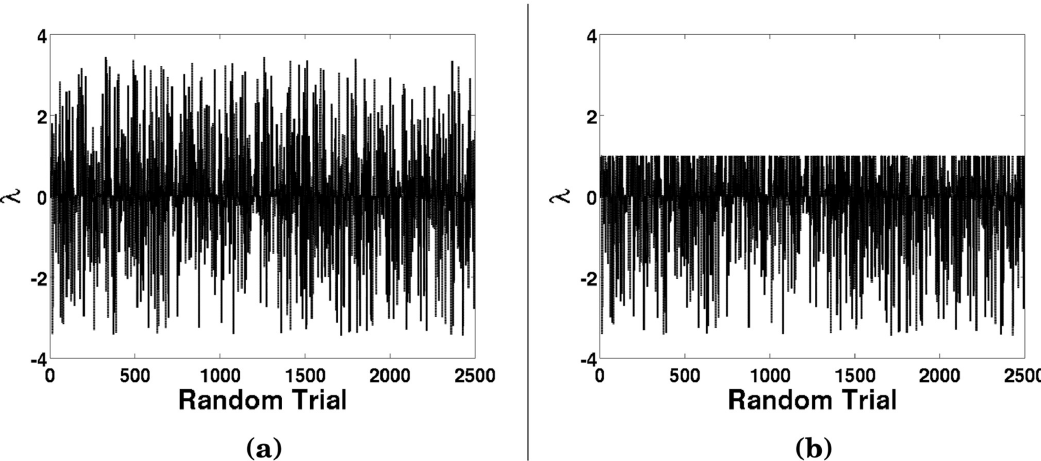
Fig 5. Monte Carlo data of random normalized asperities, both (a) before any wear and (b) after λ W = 1 of contact.